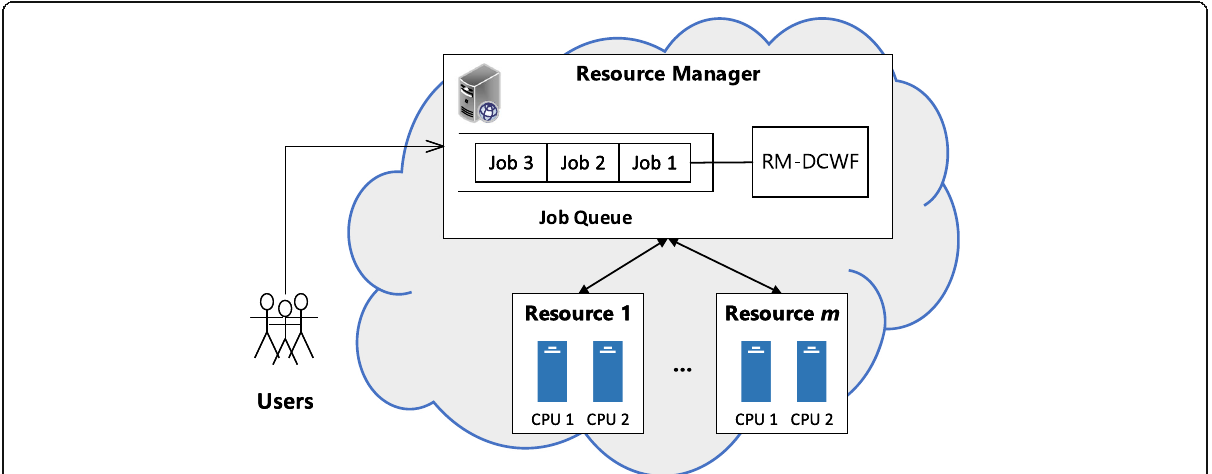
Fig. 1 Example of a system deploying